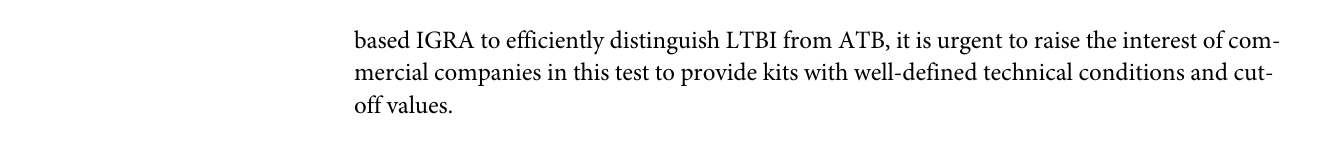
Fig 5. Summary receiver operating characteristic (ROC) curves of the HBHA-IGRA for discrimination of the LTBI and active TB. HBHA-IGRA; mycobacterial heparin-binding hemagglutinin-induced interferon-gamma release assay.